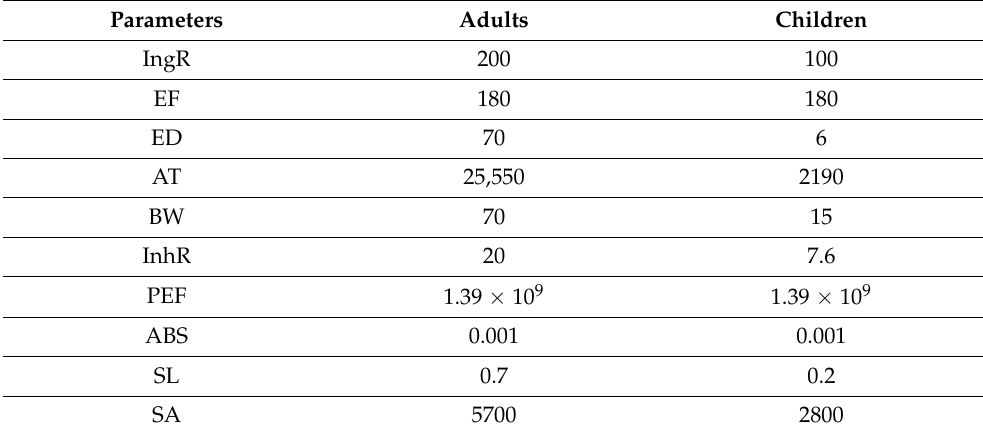
Table 2. Parameters for